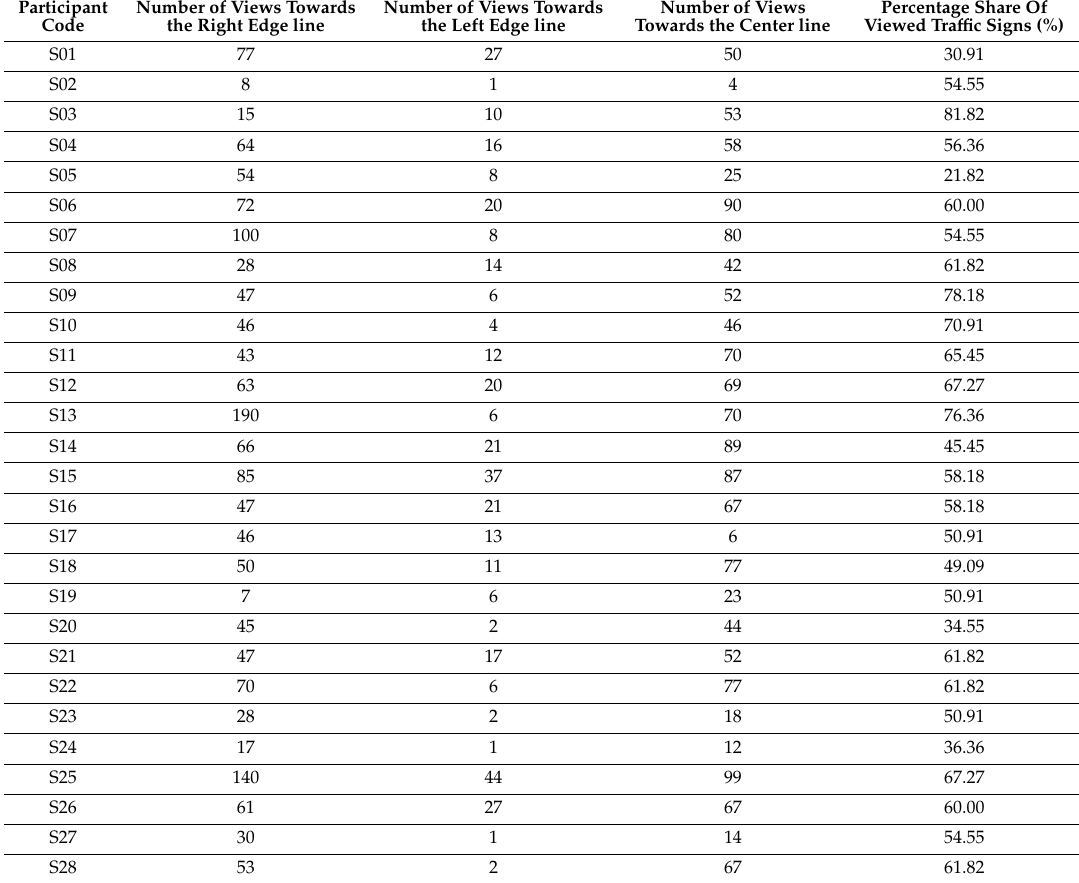
Table A2. Number of Times the Participants Viewed the Road Markings and Percentage Share of Viewed Tra ffi c